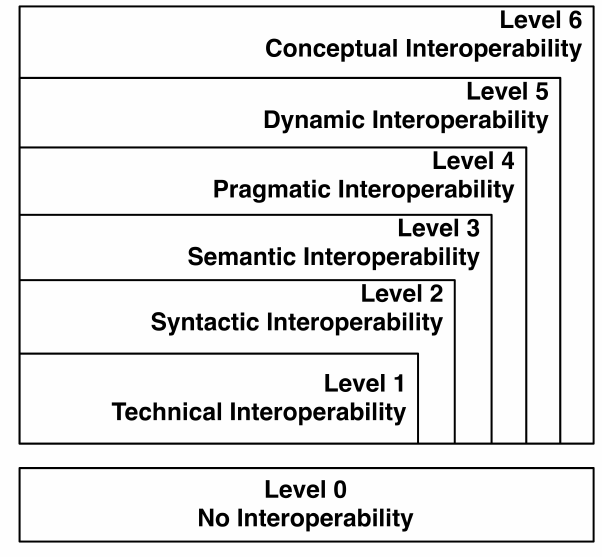
Figure 1. Levels of conceptual interoperability model (LCIM) adapted from